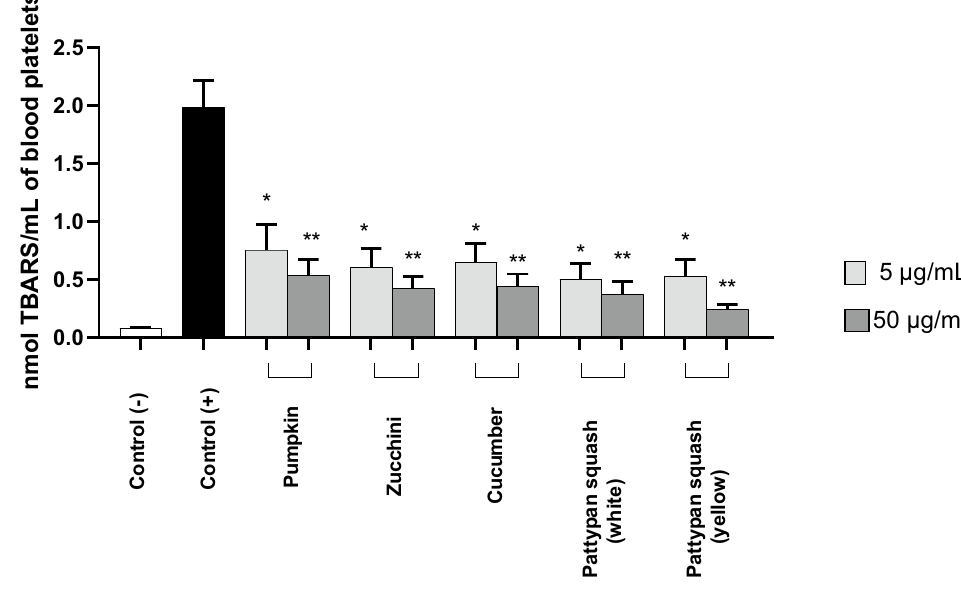
Figure 4. Effects of the five cucurbit vegetable preparations (concentrations 5 and 50 µg/mL) on lipid peroxidation in blood platelets activated by 5 U/mL thrombin (pre-incubation time with plant preparation—25 min; incubation time with thrombin—5 min). Results are given as mean ± SD (n = 5). Control negative refers to platelets not treated with thrombin, and control positive to platelets treated with thrombin. Kruskal–Wallis test: *p < 0.05, **p < 0.01. There wasn’t any statistically significant between effect of 5 and 50 µg/ mL (p > 0.05). The baseline spectral reading (absorbance) for plant preparations range between 0.00065 and